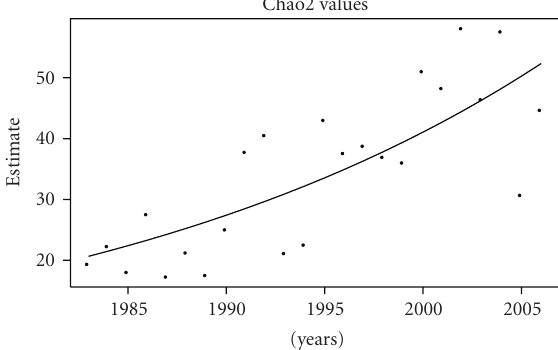
Figure 3: Plot of Chao2 data with fitted exponential